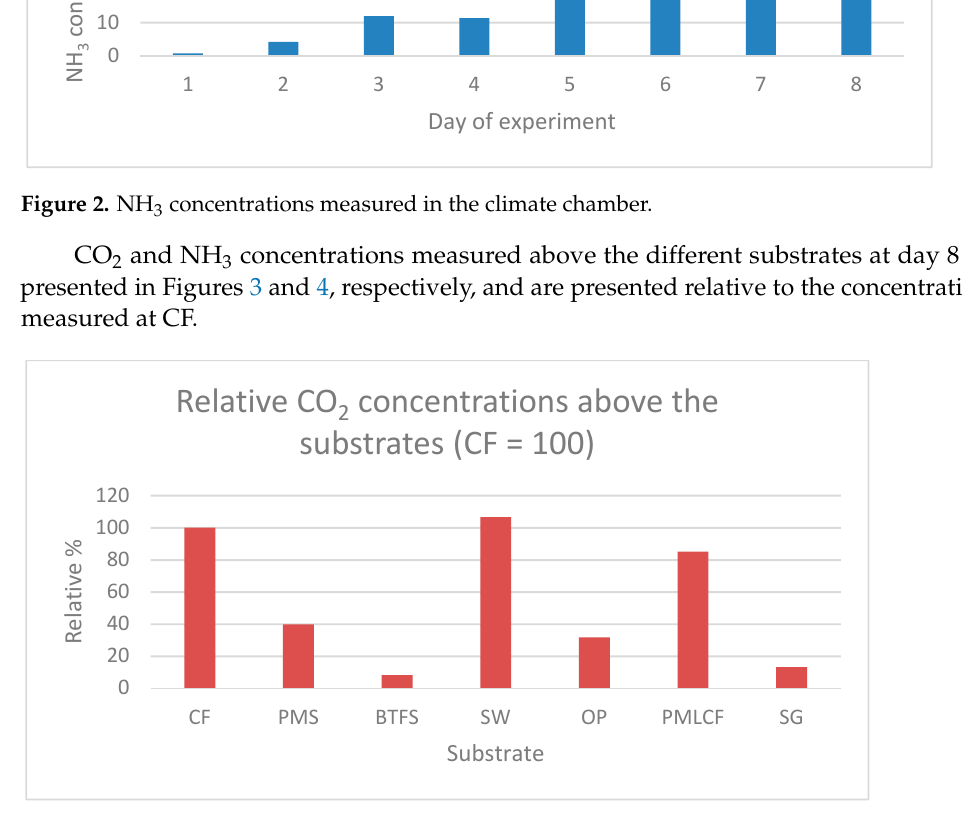
Figure 3. CO 2 concentrations measured above the individual substrates at day 8. The highest CO 2 concentrations were measured at day 8 above the substrates SW, CF, PMLCF and PMS in descending order. Lowest CO 2 concentrations were measured above the substrates OP, SG and BTFS. Figure 4. NH 3 concentrations measured above the individual substrates at day 8. The highest NH 3 concentrations were measured at day 8 above the substrates SG, OP, PMLCF and BTFS in descending order. Lowest NH 3 concentrations were measure above the substrates PMS, CF and SW. 4. Discussion This assay investigated how seven substrates affect BSF larvae bioconversion in terms of larval growth, waste reduction and conversion efficiency of ingested substrates. The larval density was 2500 starter larvae per kilogram wet substrate and was similar in all containers because from literature it is clear that larval density affects larval growth and development [16,17]. Water was added to the substrates CF and OP to make the sub- strates more optimal for growth and development of BSF larvae. There is a lack of litera- ture data on the most suitable moisture content of substrates in BSF bioconversion for effective residue separation [10] but these authors showed that the residue can be effec- tively separated from the insect biomass by sieving at 70% and 75% moisture content. For the current experiment, it was aimed to create a substrate containing about 65% moisture. Therefore, CF and OP substrates were mixed with water (1:1 w / w ) and liquid pig manure was mixed with CF (1:1 w/w ) to create PMLCF. Also, 450 mL water was added in each